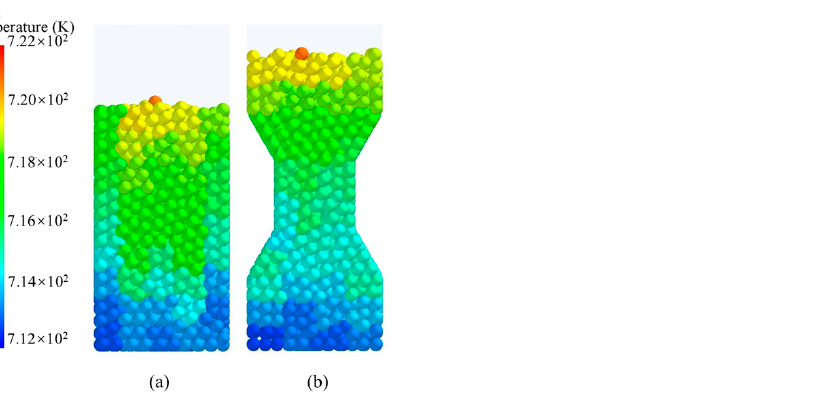
Figure 3. Sinter temperature distribution. ( a ) Sinter temperature in Case 0; ( b ) sinter temperature in Case 1.